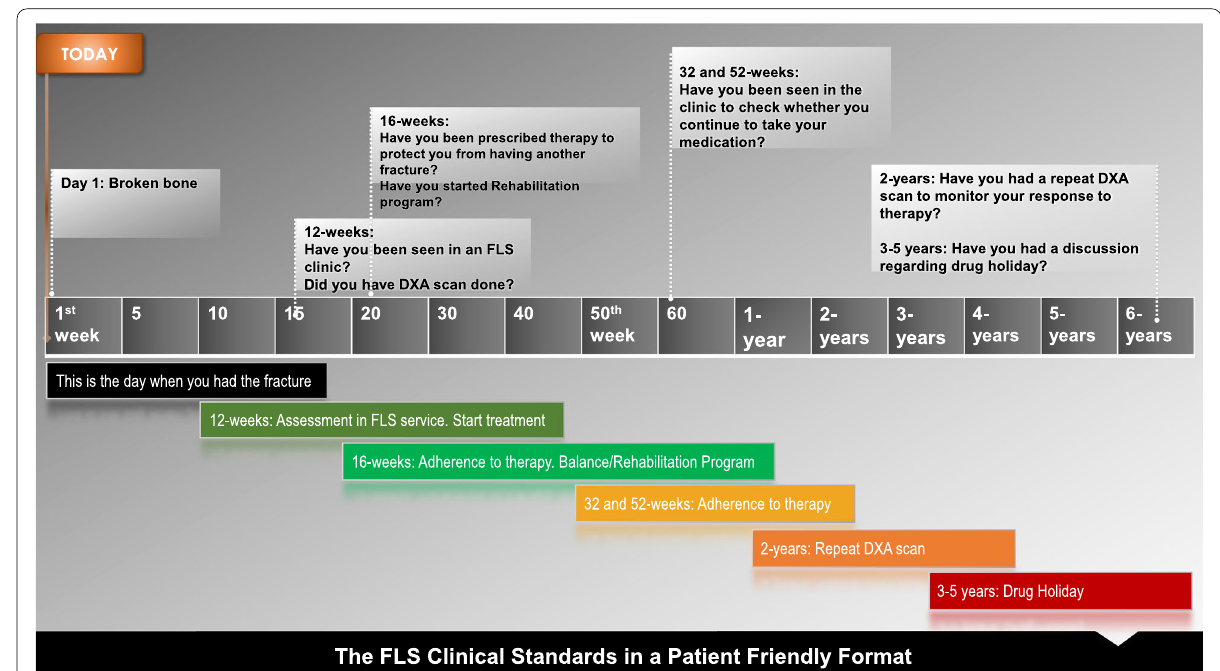
Fig. 3 The FLS clinical standards in a patient-friendly format